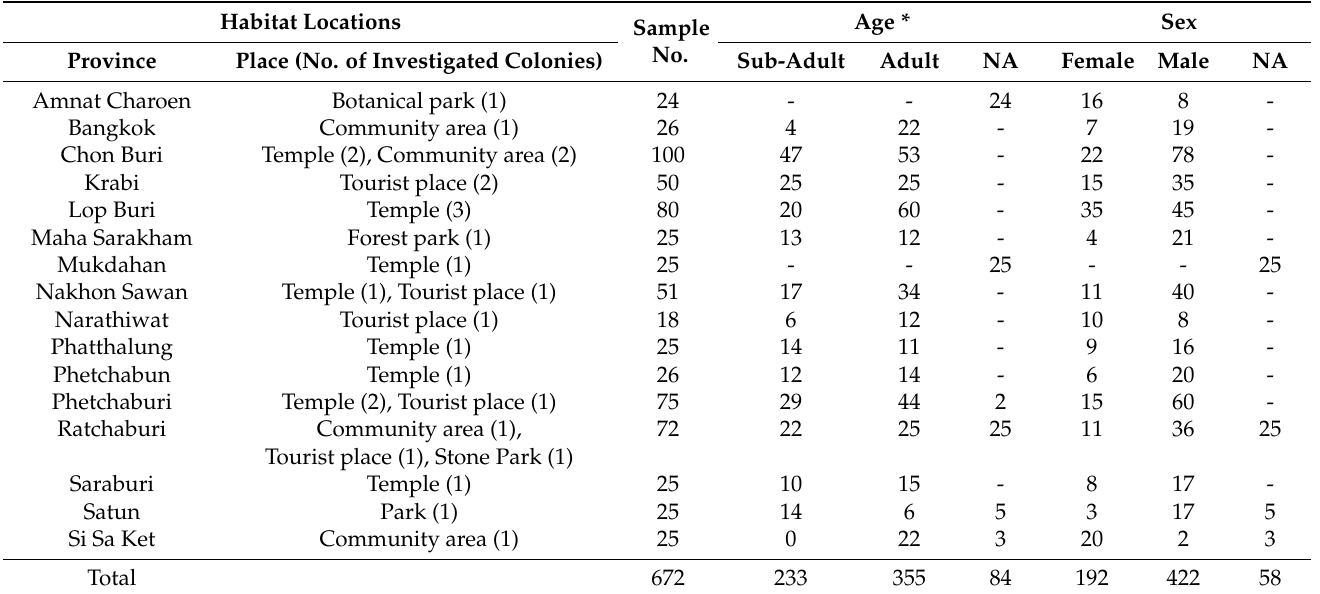
Table 1. Demographic characteristics of sera derived from free-ranging cynomolgus macaques, Thailand, March–November